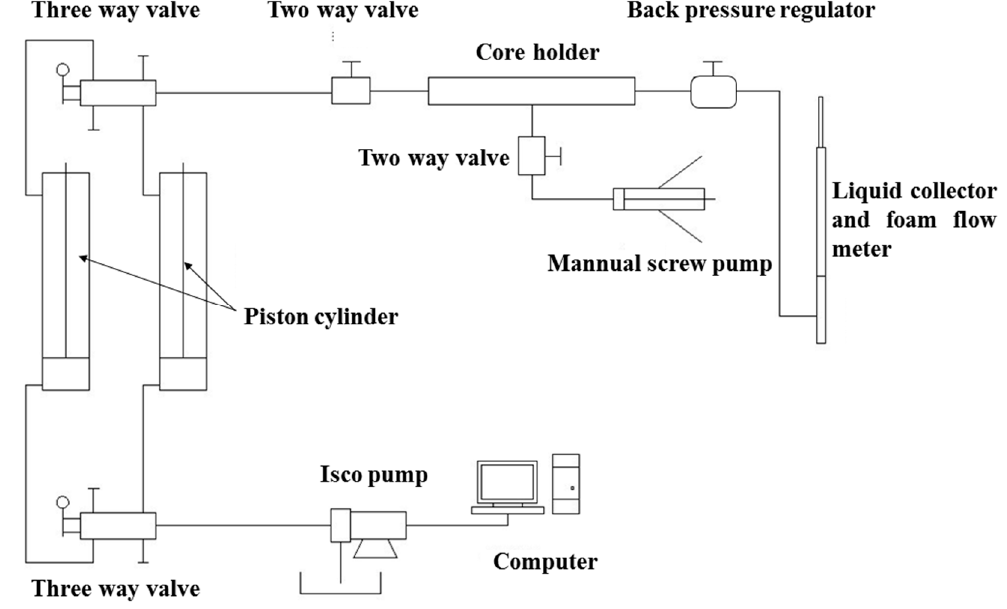
Figure 1. Acid fracturing system. Table 1. Collection of core parameters experimental data.